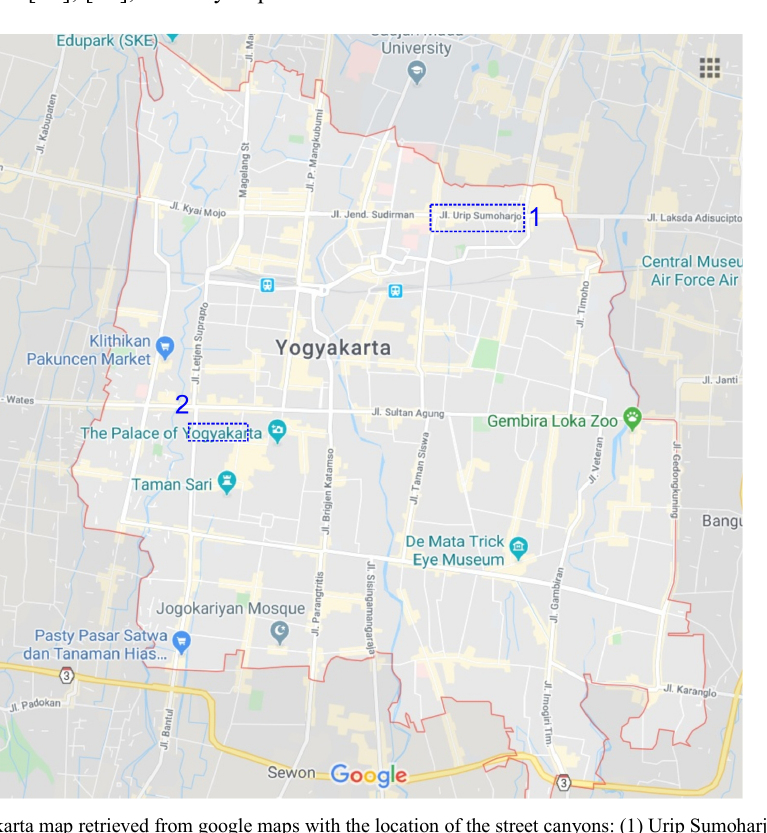
Fig. 1. Yogyakarta map retrieved from google maps with the location of the street canyons: (1) Urip Sumoharjo Street, (2) Agus Salim